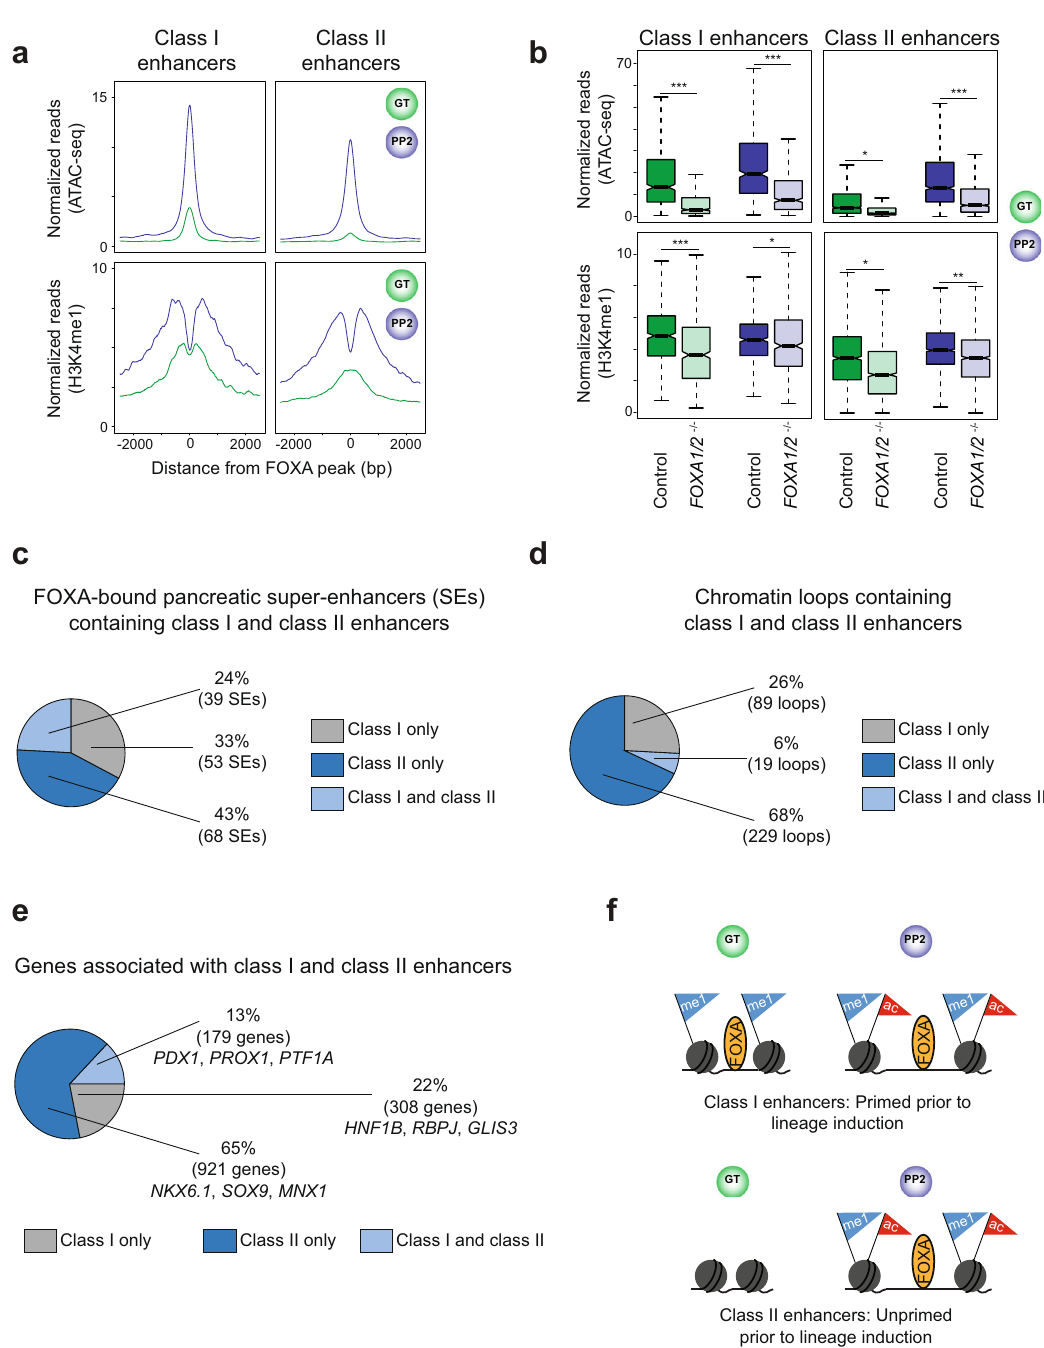
Fig. 3 Class I and class II pancreatic enhancers largely map to distinct gene regulatory elements. a Tag density plots for class I and class II pancreatic enhancers displaying ATAC-seq (top) and H3K4me1 ChIP-seq (bottom) read density in GT and PP2. Plots are centered on FOXA1/2 peaks and span 5kb. b Box plots of ATAC-seq (top) and H3K4me1 ChIP-seq (bottom) counts at class I and class II pancreatic enhancers in GT and PP2 for control and FOXA1/2 − / − cells ( P = <2.2×10 − 16 , <2.2×10 − 16 , 0.01, and <2.2×10 − 16 for control versus FOXA1/2 − / − of ATAC-seq signal at class I in GT, class I in PP2, class II in GT, and class II in PP2, respectively. P = <2.2×10 − 16 , 0.01, 0.02, and 0.01 for control versus FOXA1/2 − / − of H3K4me1 signal at class I in GT, class I in PP2, class II in GT, and class II in PP2, respectively; Wilcoxon rank sum test, 2-sided). Plots are centered on median, with box encompassing 25th – 75th percentile and whiskers extending up to 1.5 interquartile range. c Percentage of FOXA1- and/or FOXA2-bound pancreatic super-enhancers (SEs) in PP2 containing only class I, only class II, or both class I and class II enhancers. d Percentage of chromatin loop anchors in PP2 containing only class I, only class II, or both class I and class II enhancers. e Percentage of genes associated with only class I, only class II, or both class I and class II enhancers. Target genes were assigned to enhancers based on nearest TSS of expressed genes (fragments per kilobase per million fragments mapped (FPKM) ≥ 1) in PP2. f Schematic illustrating FOXA1/2 occupancy, chromatin accessibility, and presence of H3K4me1 and H3K27ac at class I and class II enhancers in GT and PP2. All ChIP-seq and ATAC-seq experiments, n = 2 replicates from independent